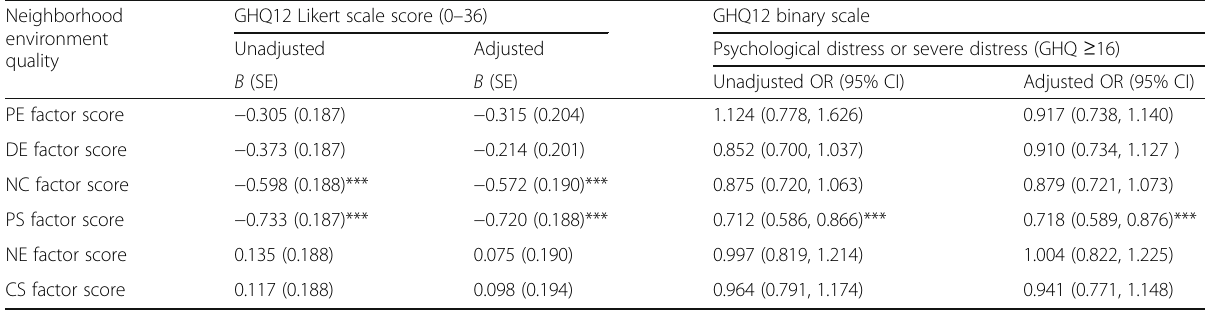
Table 5 Association between perceived neighborhood environment and self-reported mental health ( n = 719) Neighborhood